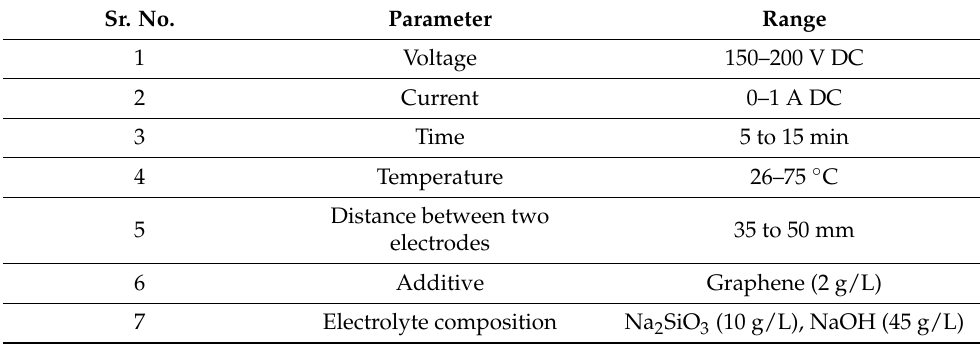
Table 2. Input Parameter details of the PEO